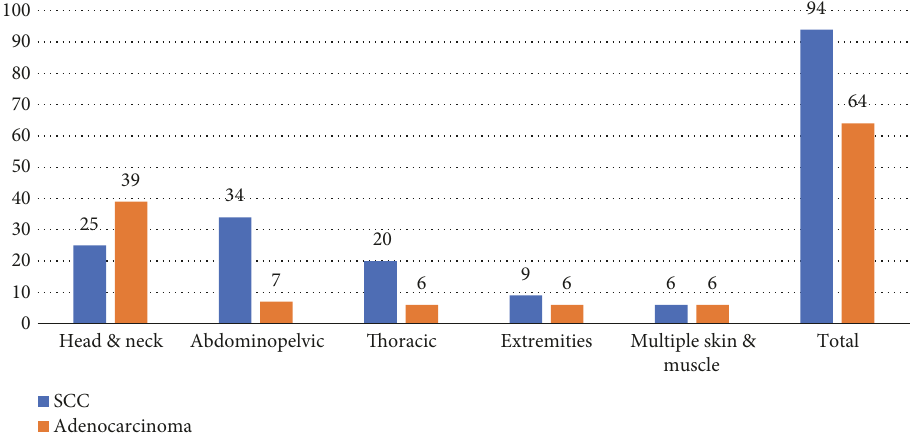
Figure 5: ECM anatomic location in fl uence on pathological rate.